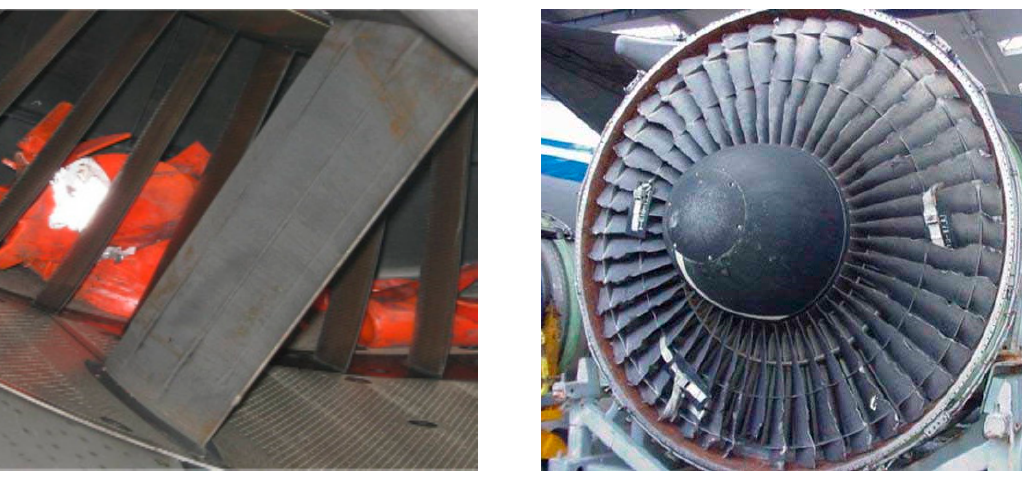
Figure 2. Elements sucked in by the engine. Source: [5,6].